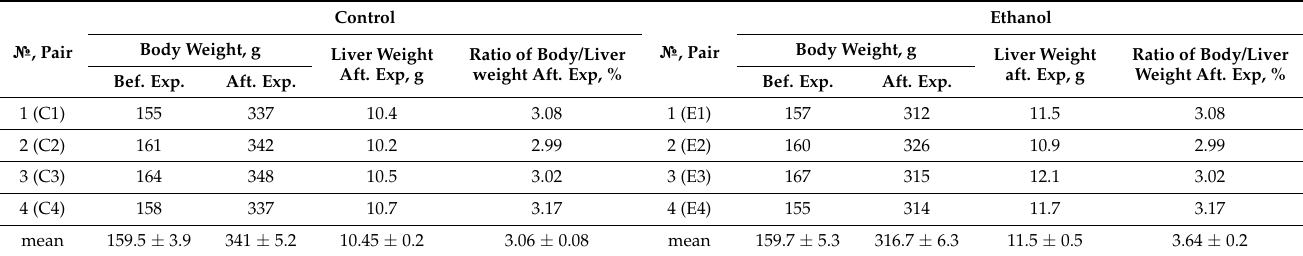
Table 1. Changes in weight characteristics after the ethanol treatment of